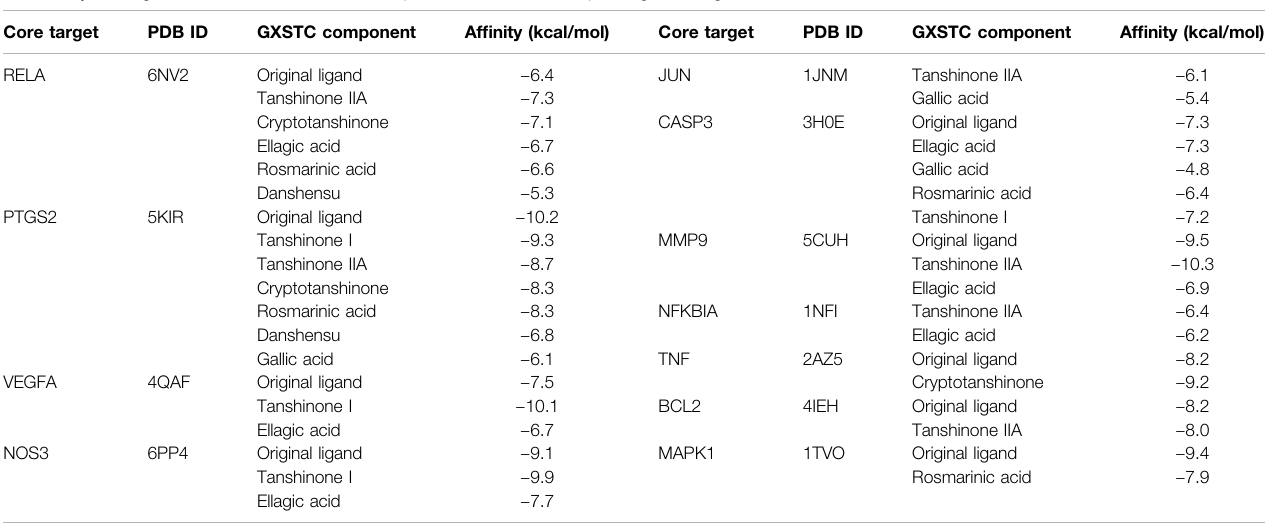
TABLE 1 | Docking scores between seven core components and their corresponding core